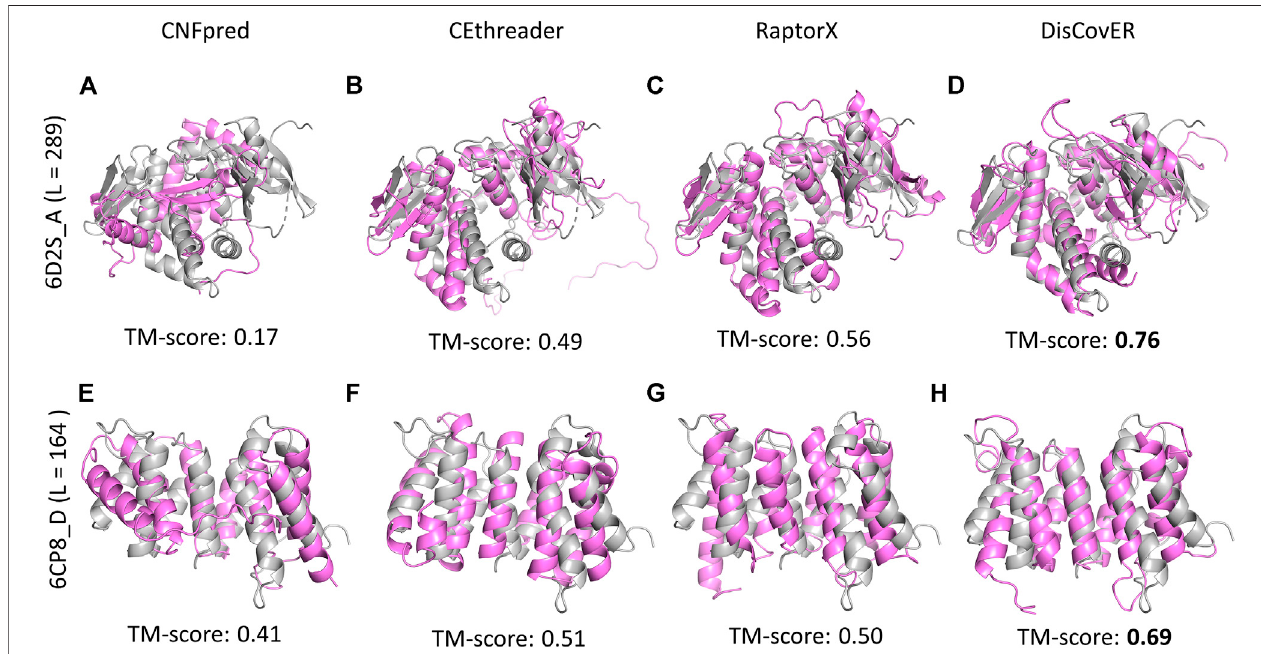
FIGURE2| Structuralsuperpositionbetweenpredicted modelsusingvariousthreadingmethods(inviolet)andthecorrespondingexperimentalstructures(ingray) for representative CAMEO targets 6D2S_A of length 289 residues and 6CP8_D of length 164 residues.